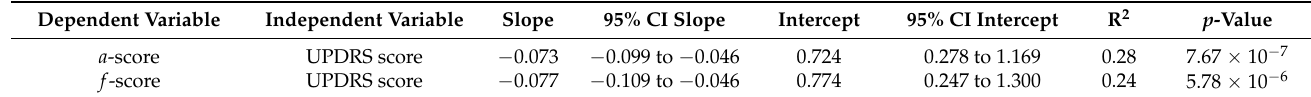
Figure 3. Linear regression with 95% confident bounds of a -score vs. UPDRS score and f -score vs. UPDRS score. Table 5. Results of the linear regression analyses.